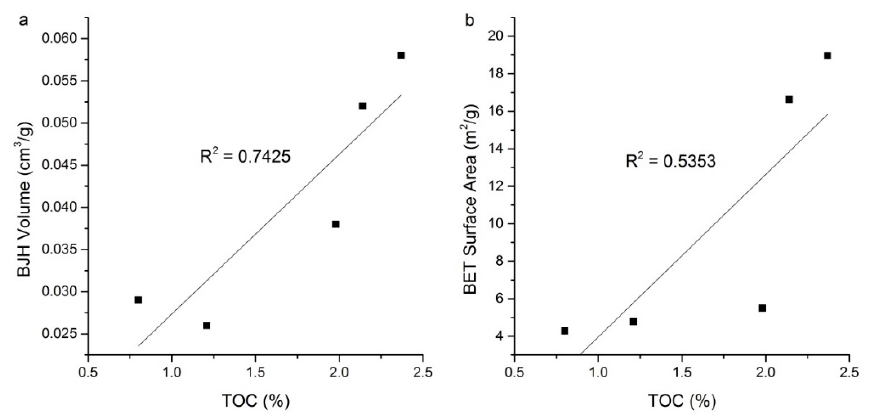
Figure 11. Relationships between pore structure parameters and TOC contents (mass fraction). ( a ) BJH volume; ( b ) BET surface area. R 2 is the correlation coefficient.